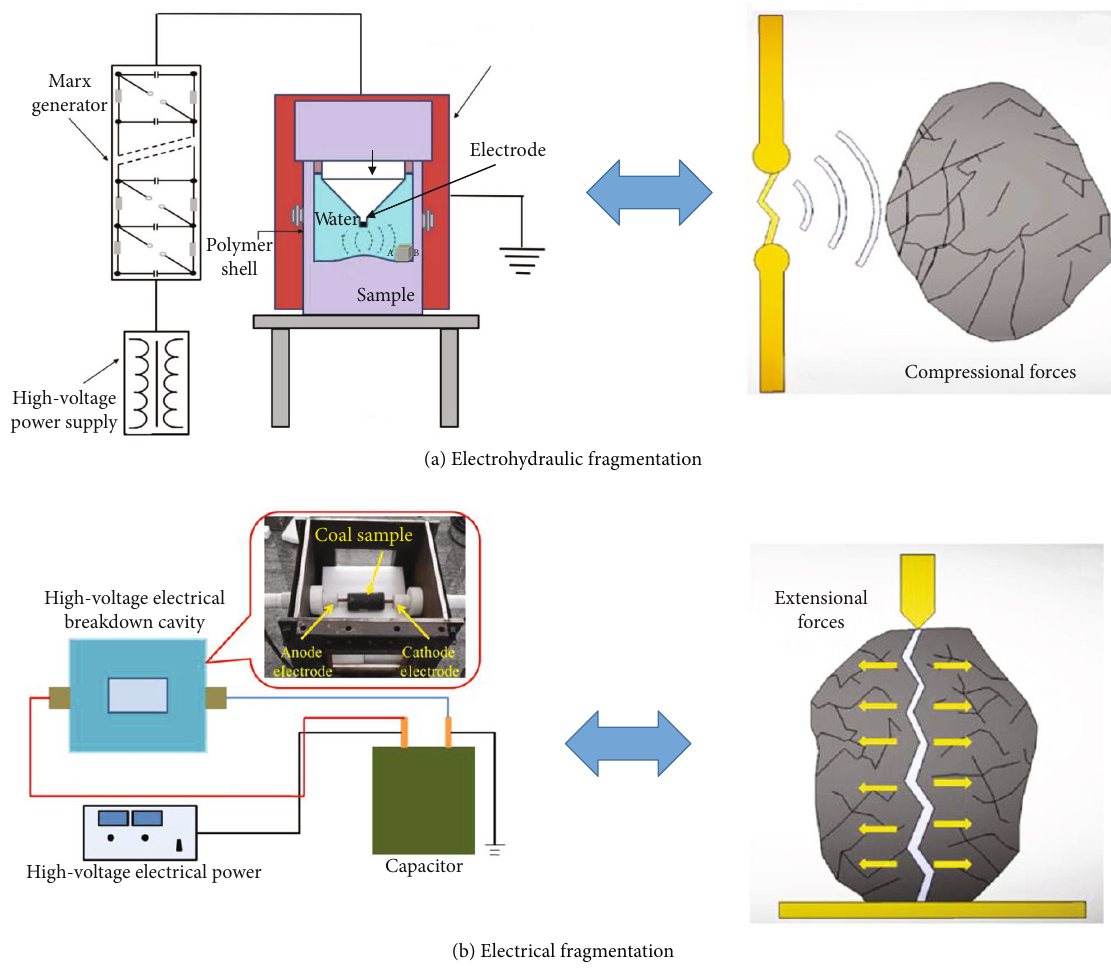
Figure 10: Schematic diagram of two kinds of high-voltage electric fracturing and their principles [53,